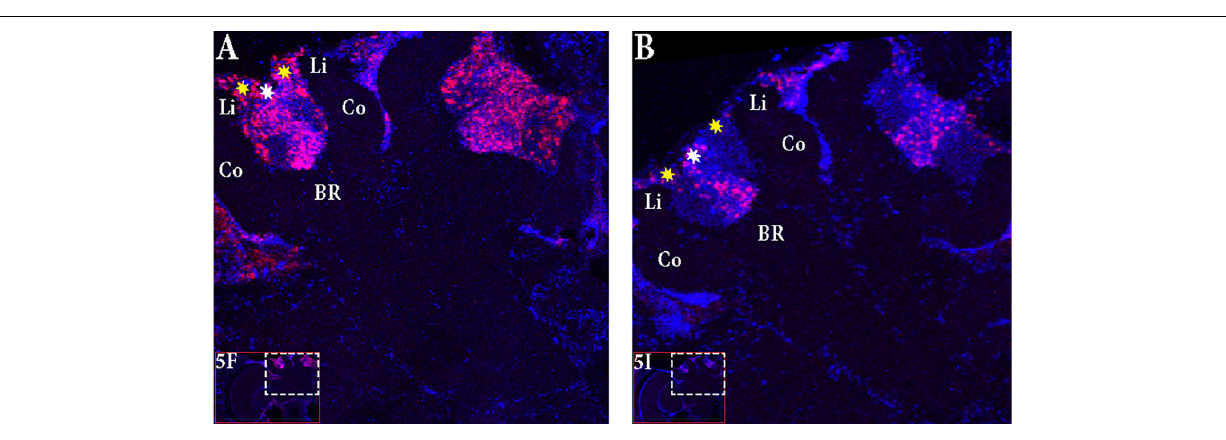
memory processes (Mizunami et al., 1998; Hourcade et al., 2010; Lefer et al., 2012), we focused for now, on the expression in the MBs. Within the MBs, the small Kenyon cells (sKCs) showed